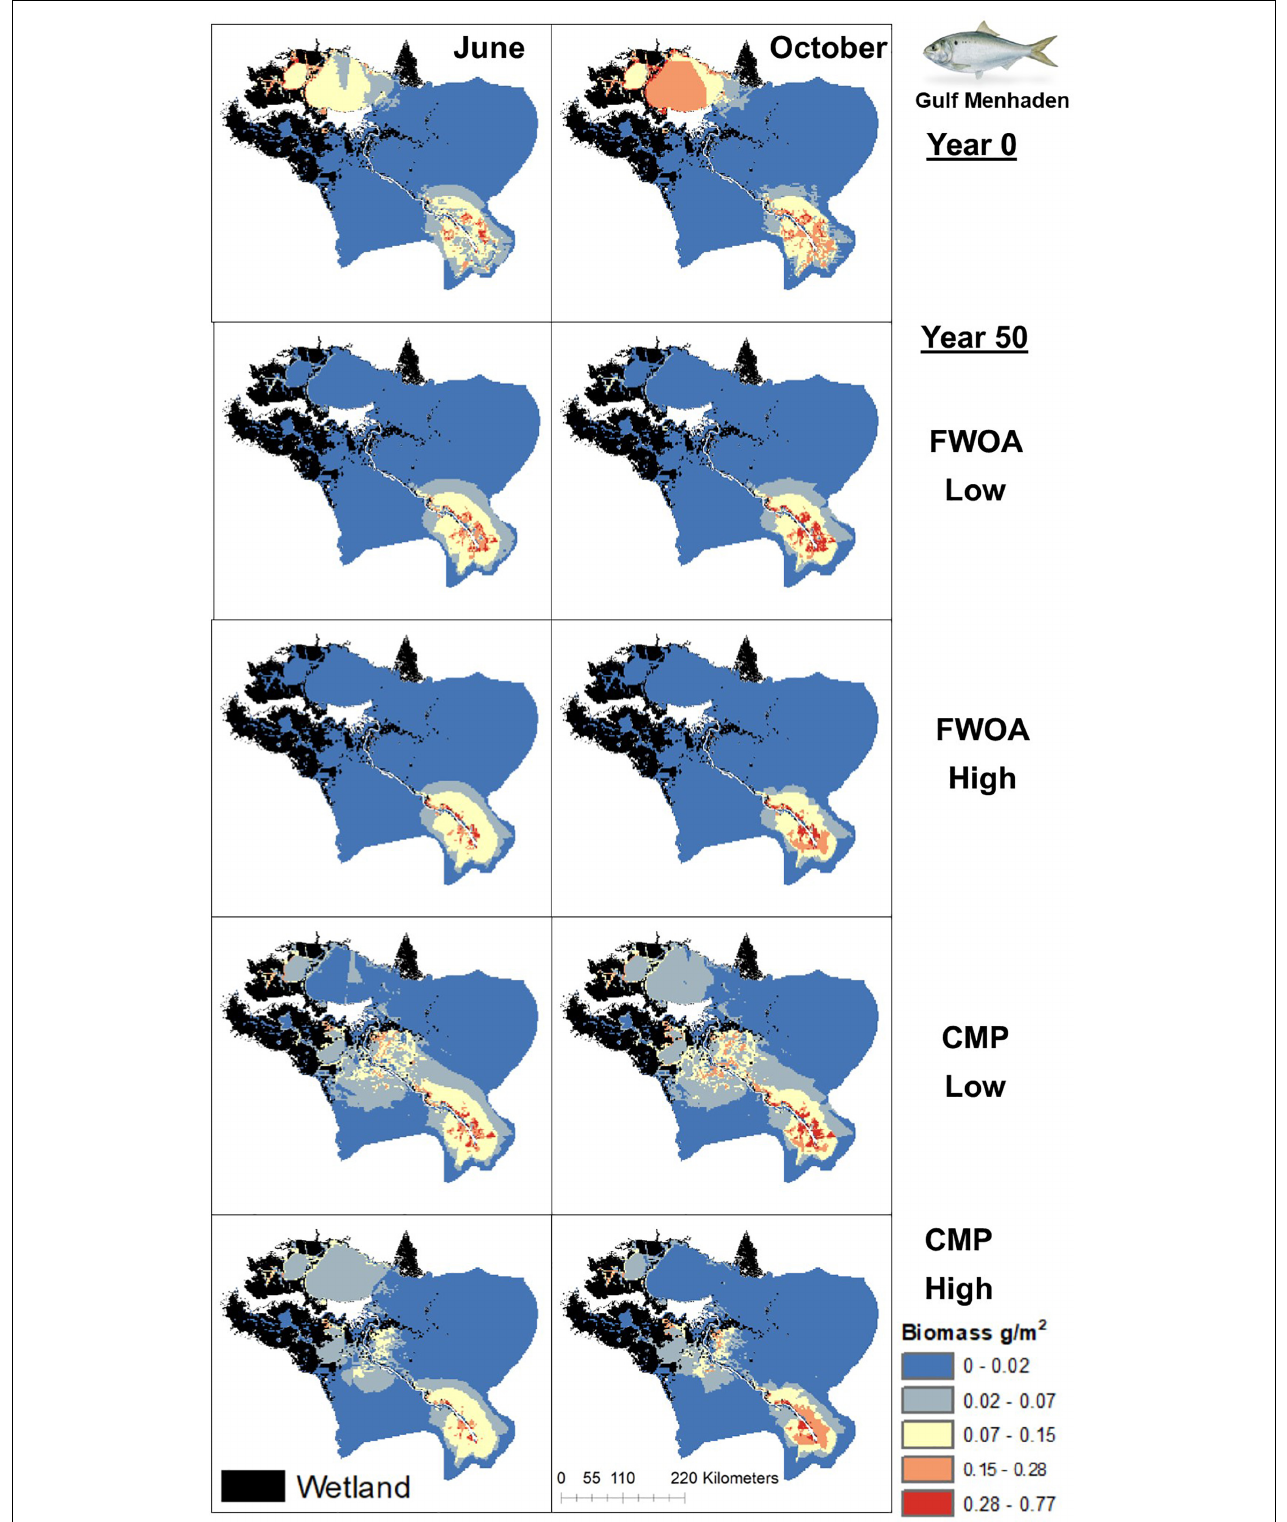
FIGURE 9 | Spatial distribution of juvenile Gulf Menhaden in different simulations. Output is shown from June and October in Year 0 and Year 50, under “Low” and “High” relative sea level rise (see Supplementary Table S6 for scenarios), and with Coastal Master Plan (CMP) implementation and without (FWOA).